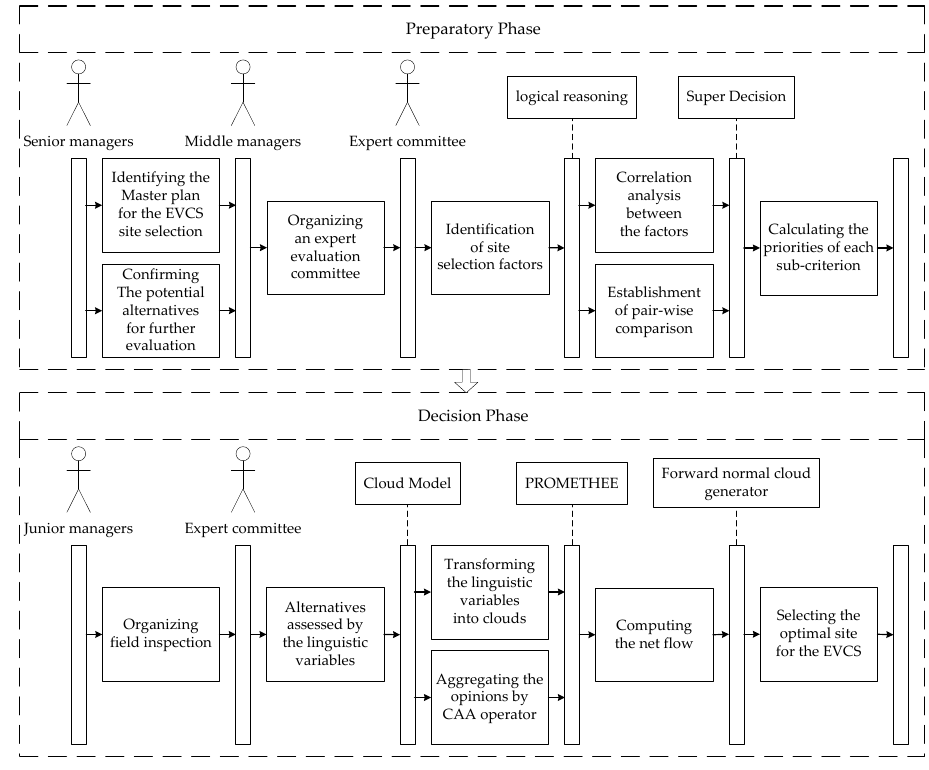
Figure 1. The decision system for the EVCS site selection.